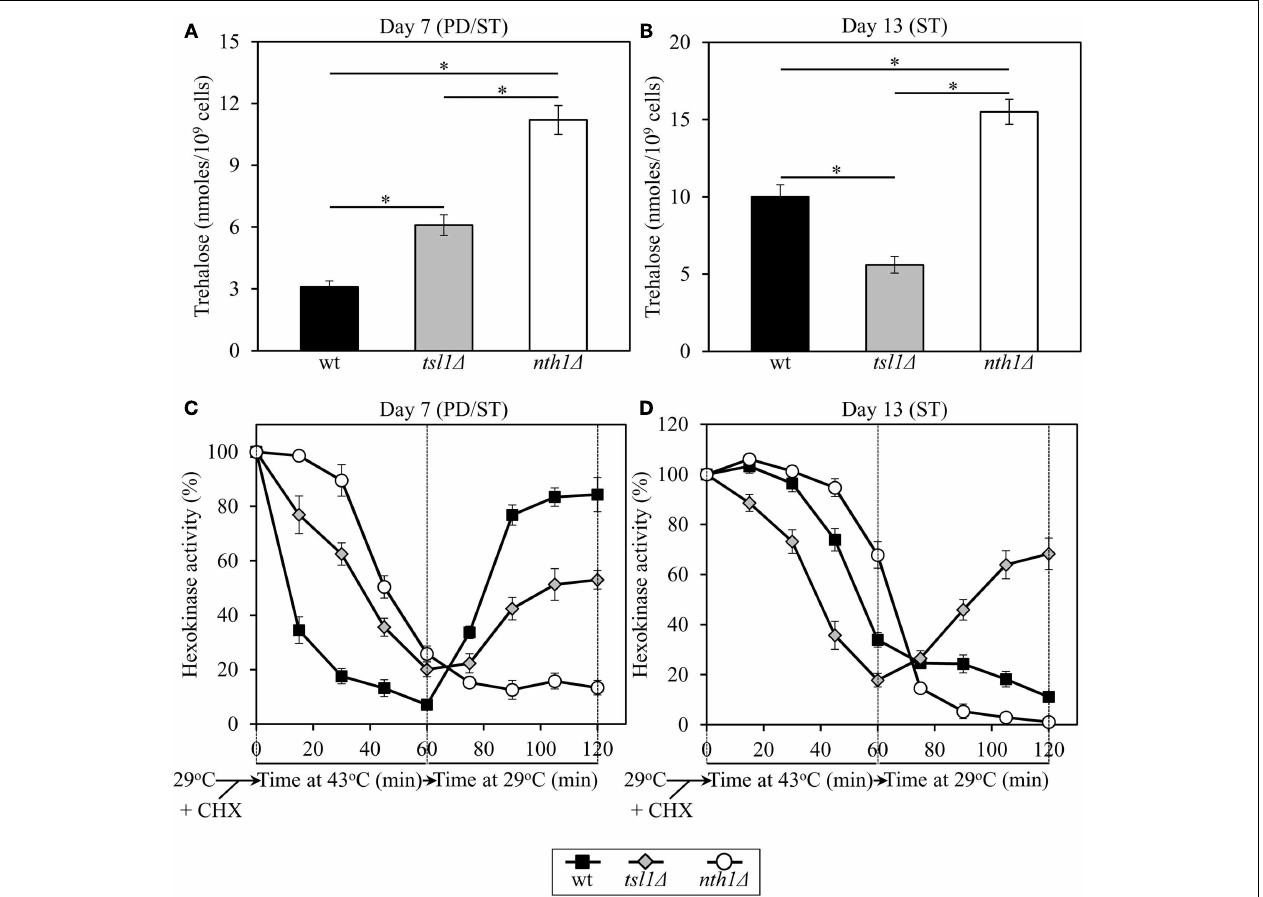
60min. (A,B) The intracellular levels of trehalose prior to cell treatment with cycloheximide. (C,D) Changes in hexokinase enzymatic activity following cell exposure to cycloheximide, during heat shock treatment for 60min at 43˚C, and subsequent incubation for 60min at 29˚C. wt, tsl1 ∆ and nth1 ∆ cells were cultured inYP medium initially containing 0.2% glucose. Data are presented as mean ± SEM ( n = 3–5). Abbreviations: CHX, cycloheximide; PD, post-diauxic growth phase; ST, stationary growth